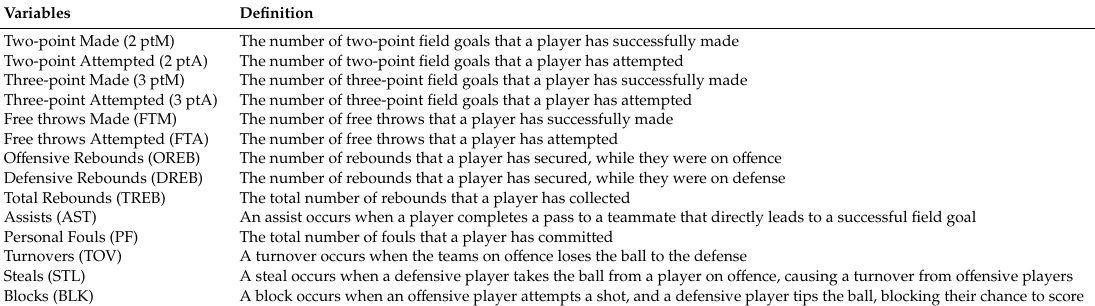
Table 1. The variables selected in current